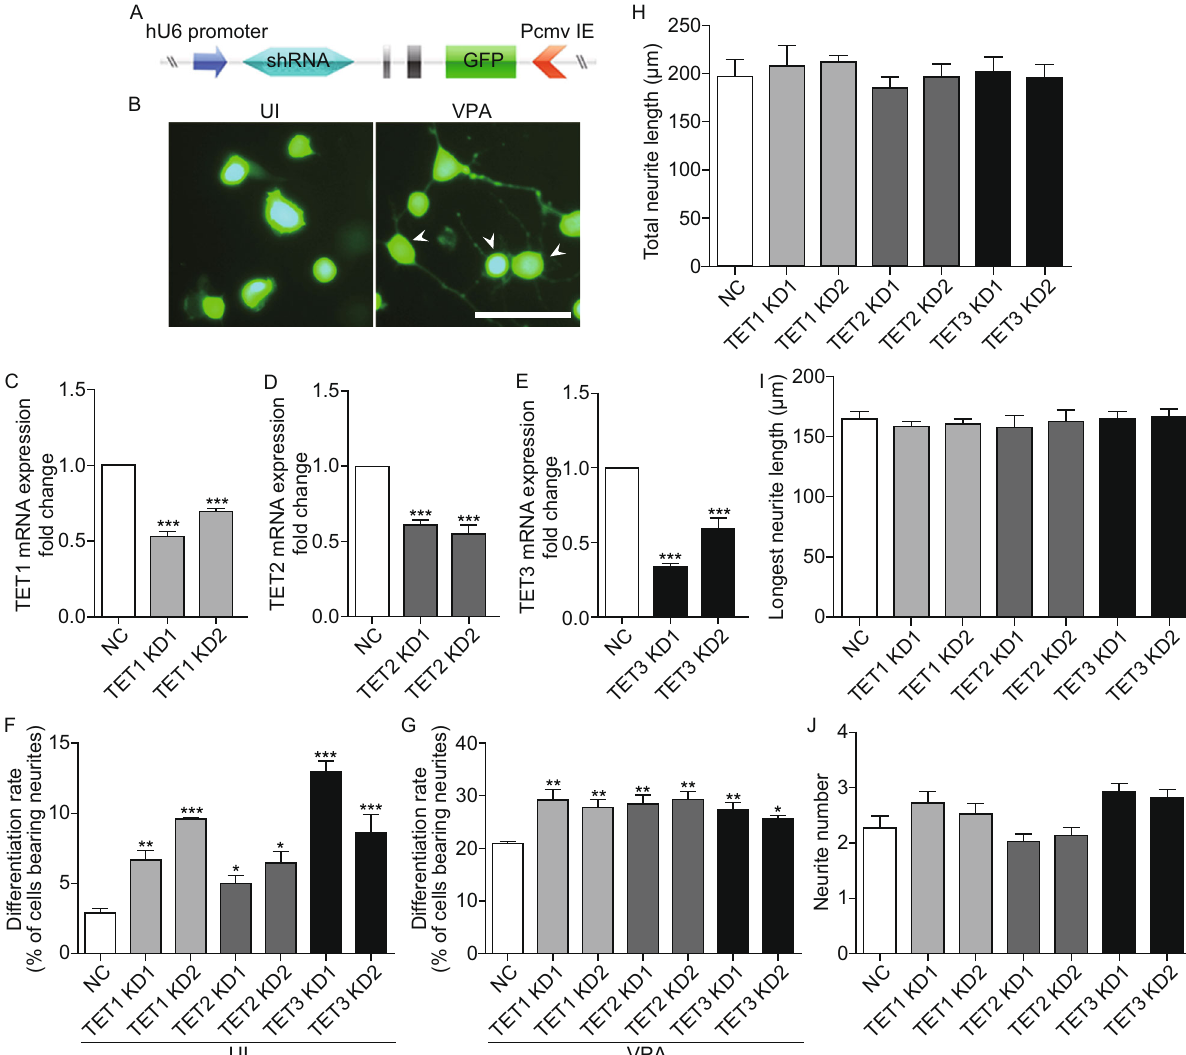
UI Figure 2. Knockdown of TET proteins facilitate the neuronal differentiation of Neuro2a cells. (A) Schematic presentation of shRNA expression vector. hU6 promoter, human U6 promoter; Pcmv IE, cytomegalovirus immediate-early promoter; GFP, green fl uorescent protein. Neuro2a cells transfected with shRNA expression vectors were visualized by GFP. (B) Representative images of uninduced Neuro2a cells (UI) and Neuro2a cells after VPA stimulation (VPA) for 24 h. Arrowheads indicate the differentiated cells. Cells with processes longer than 1.5 cell bodies are considered as differentiated cells. Scale bar = 100 μ m. (C – E) shRNA expression vectors of TET1 – 3 were transfected into Neuro2a cells, and qRT-PCR was used to analyze the effects of TET proteins knockdown. GAPDH was used as internal control. (F and G) Quanti fi cations of the differentiation rates from Neuro2a cells of negative control (NC) and TET1, TET2, or TET3 knockdown in the absence (UI) or presence of VPA stimulation (VPA) for 24 h. Two shRNAs targeted different positions were designed respectively for each gene. (H – J) Assessment of neurite outgrowth of VPA-induced Neuro2a